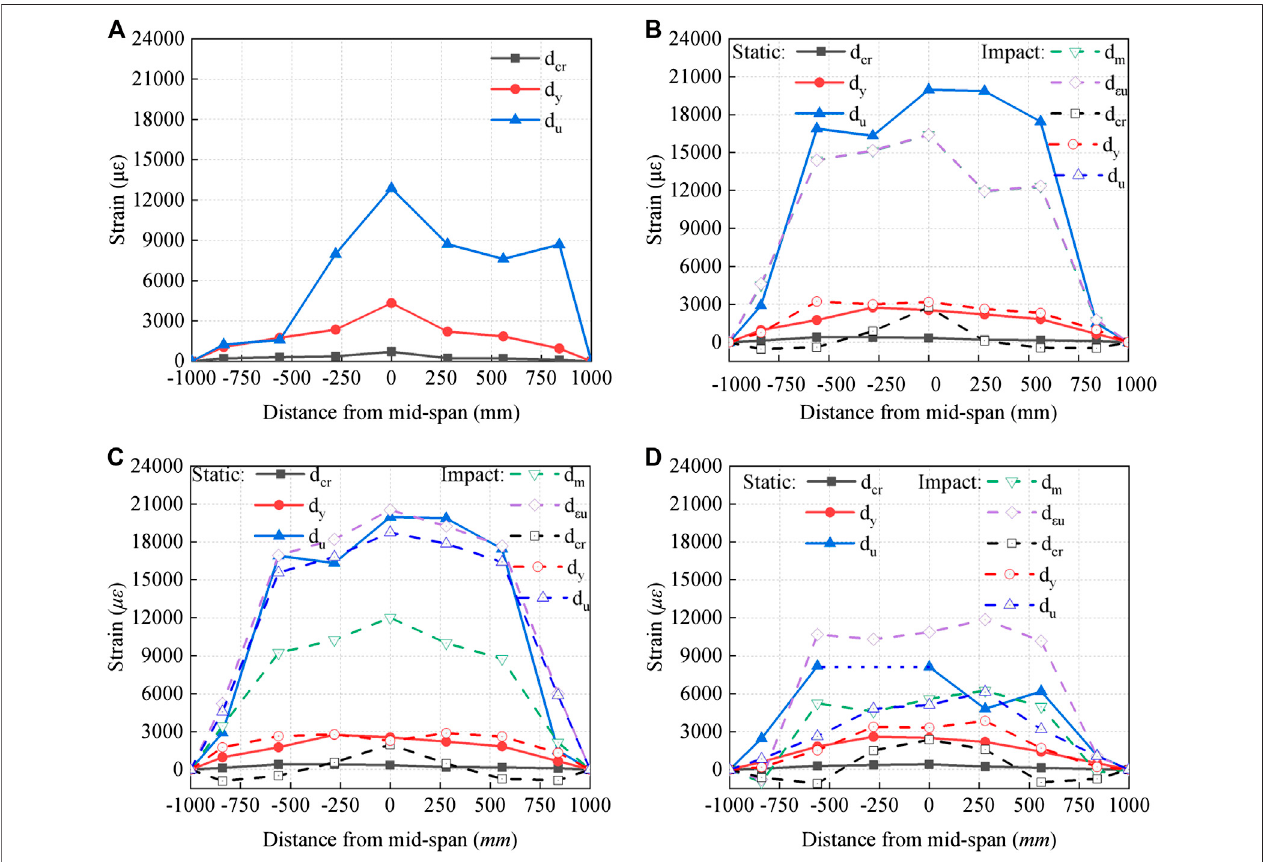
FIGURE 12 | FRP strain distribution. (A) EP-S, (B) AP-D1 and AP-S, (C) AP-D2 and AP-S, (D) AC-D1 and AC-S.